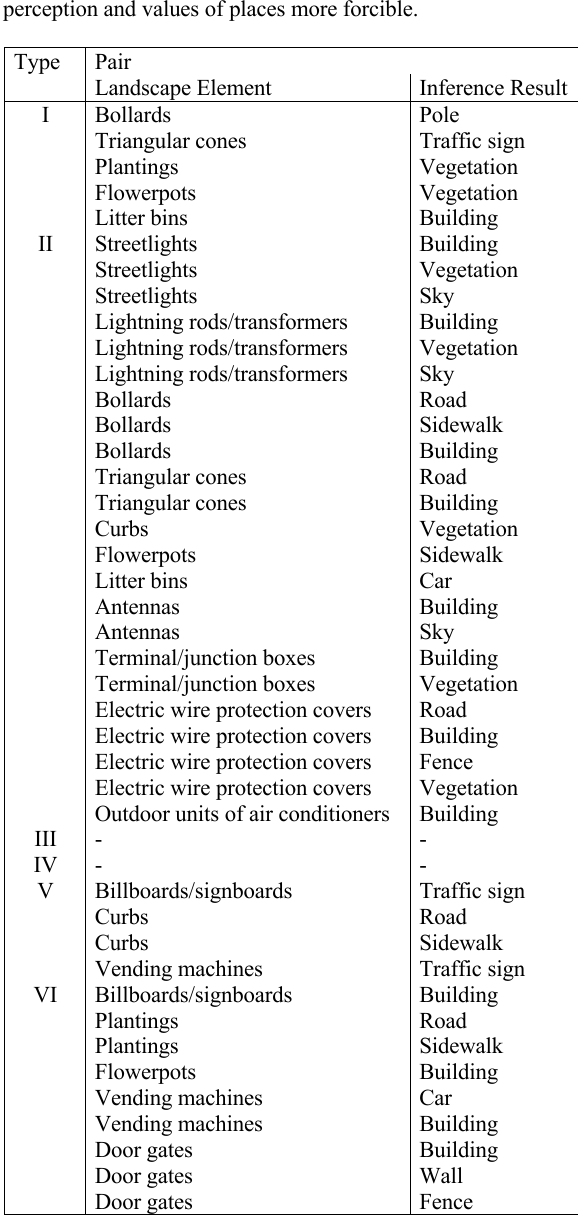
Table 8 . Pairs of elements and their corresponding false inference types (Those categorized into void